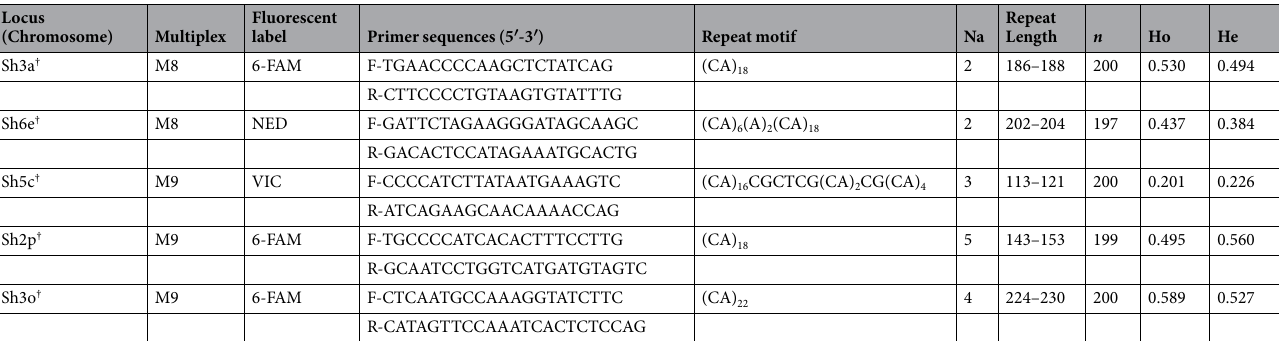
Table 2. Characteristics of the 33 microsatellites used to genotype Tasmanian devils. * Current study. † Jones et al . 41 . Na = number of alleles observed for microsatellites, H o = observed heterozygosity and H e = expected